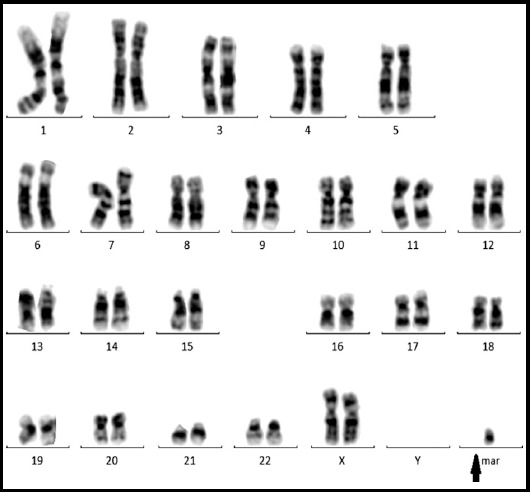
A Karyotype of the female with an extra Small supernumerary marker chromosomes, 7,XX,+mar.